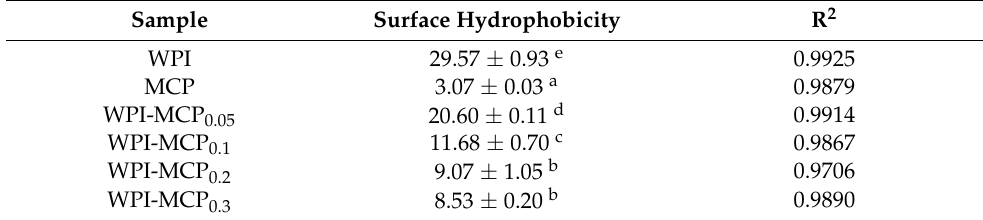
Table 1. The surface hydrophobicity of WPI, MCP and WPI-MCP conjugates.